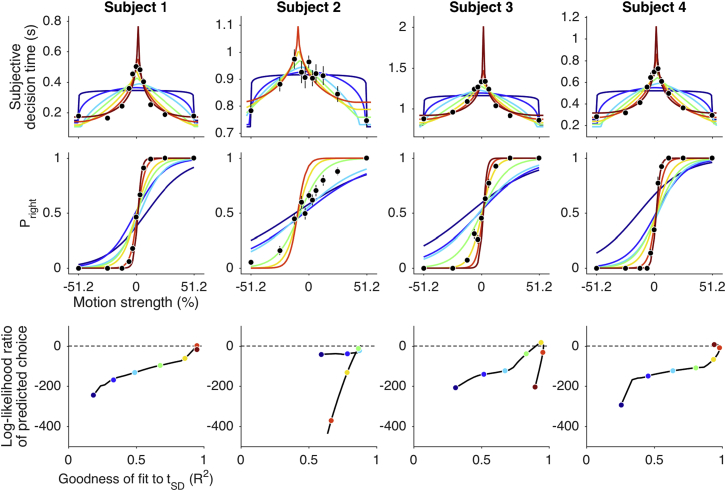
Many Possible Clock Reports Could Reflect Motion Strength but Would Furnish Inferior Predictions of Choice BehaviorThe tSDs and choice proportions are shown by the black points in the upper two rows (same data as in Figure 2; subjects 1–4). Top row: examples of possible functions of difficulty generated from reflected cumulative beta distributions, scaled and shifted to best fit the observed tSDs. These functions were used to produce surrogate clock settings at the 11 values of motion strength. Middle row: examples of predicted choice functions using the surrogate clock times from the functions in the top row (corresponding colors). The surrogate clock settings (tsurr) were fit by Equation 2 to derive parameters that specify the choice function (Equation 1). Bottom row: comparison of the quality of the predictions from surrogate clock times to the prediction obtained from the observed tSDs. Log-likelihood ratio of the choice predictions is shown as a function of the degree to which the surrogates approximate the real data (R2) for a range of possible functions (black trace). The examples in the upper rows are shown by colored points. Log-likelihood ratio less than zero indicates inferior predictions from the surrogate times compared to the observed tSDs. Only functions that do not distort the observed tSDs (R2≈1) predict the choice functions as well as the data. See also Figure S2.